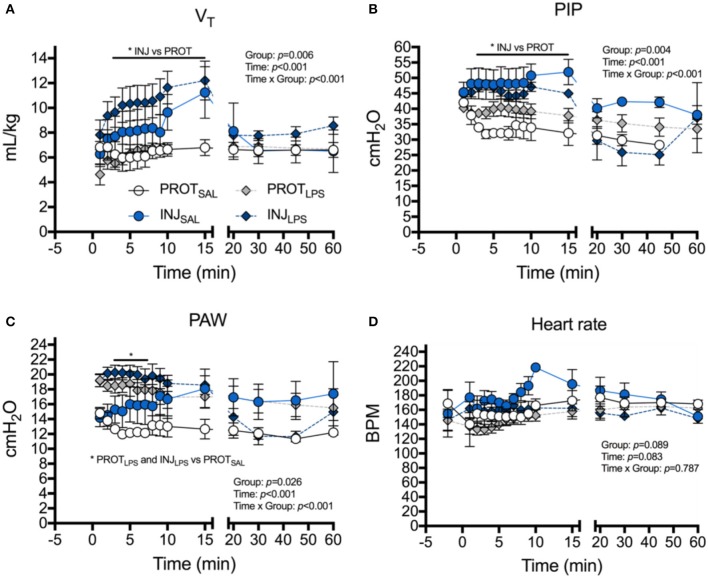
Effects of ventilation strategy and LPS exposure on ventilator requirements and heart rate. Changes in tidal volume (VT), (A), peak inspiratory pressure (PIP) (B), mean airway pressure (PAW) (C) and heart rate (D), in the PROTSAL (white circles), INJSAL (blue circles), PROTLPS (gray diamonds) and INJLPS (dark blue diamonds) lambs. PROTSAL, N = 5; PROTLPS, N = 6; INJSAL, N = 6; and INJLPS, N = 5. *p < 0.05.